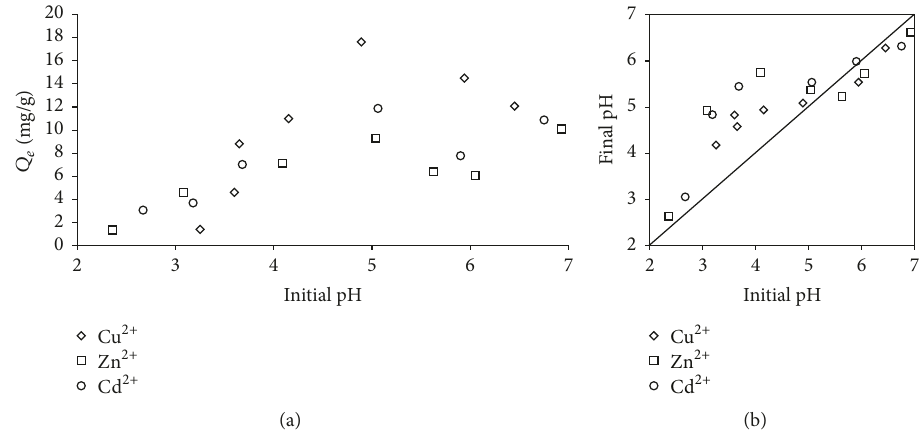
Figure 8: (a) Effect of initial solution pH and (b) initial solution pH versus final solution pH for the removal of Cu 2+ , Zn 2+ , and Cd 2+ by the zirconium-based ferromagnetic sorbent [experimental condition: initial concentration